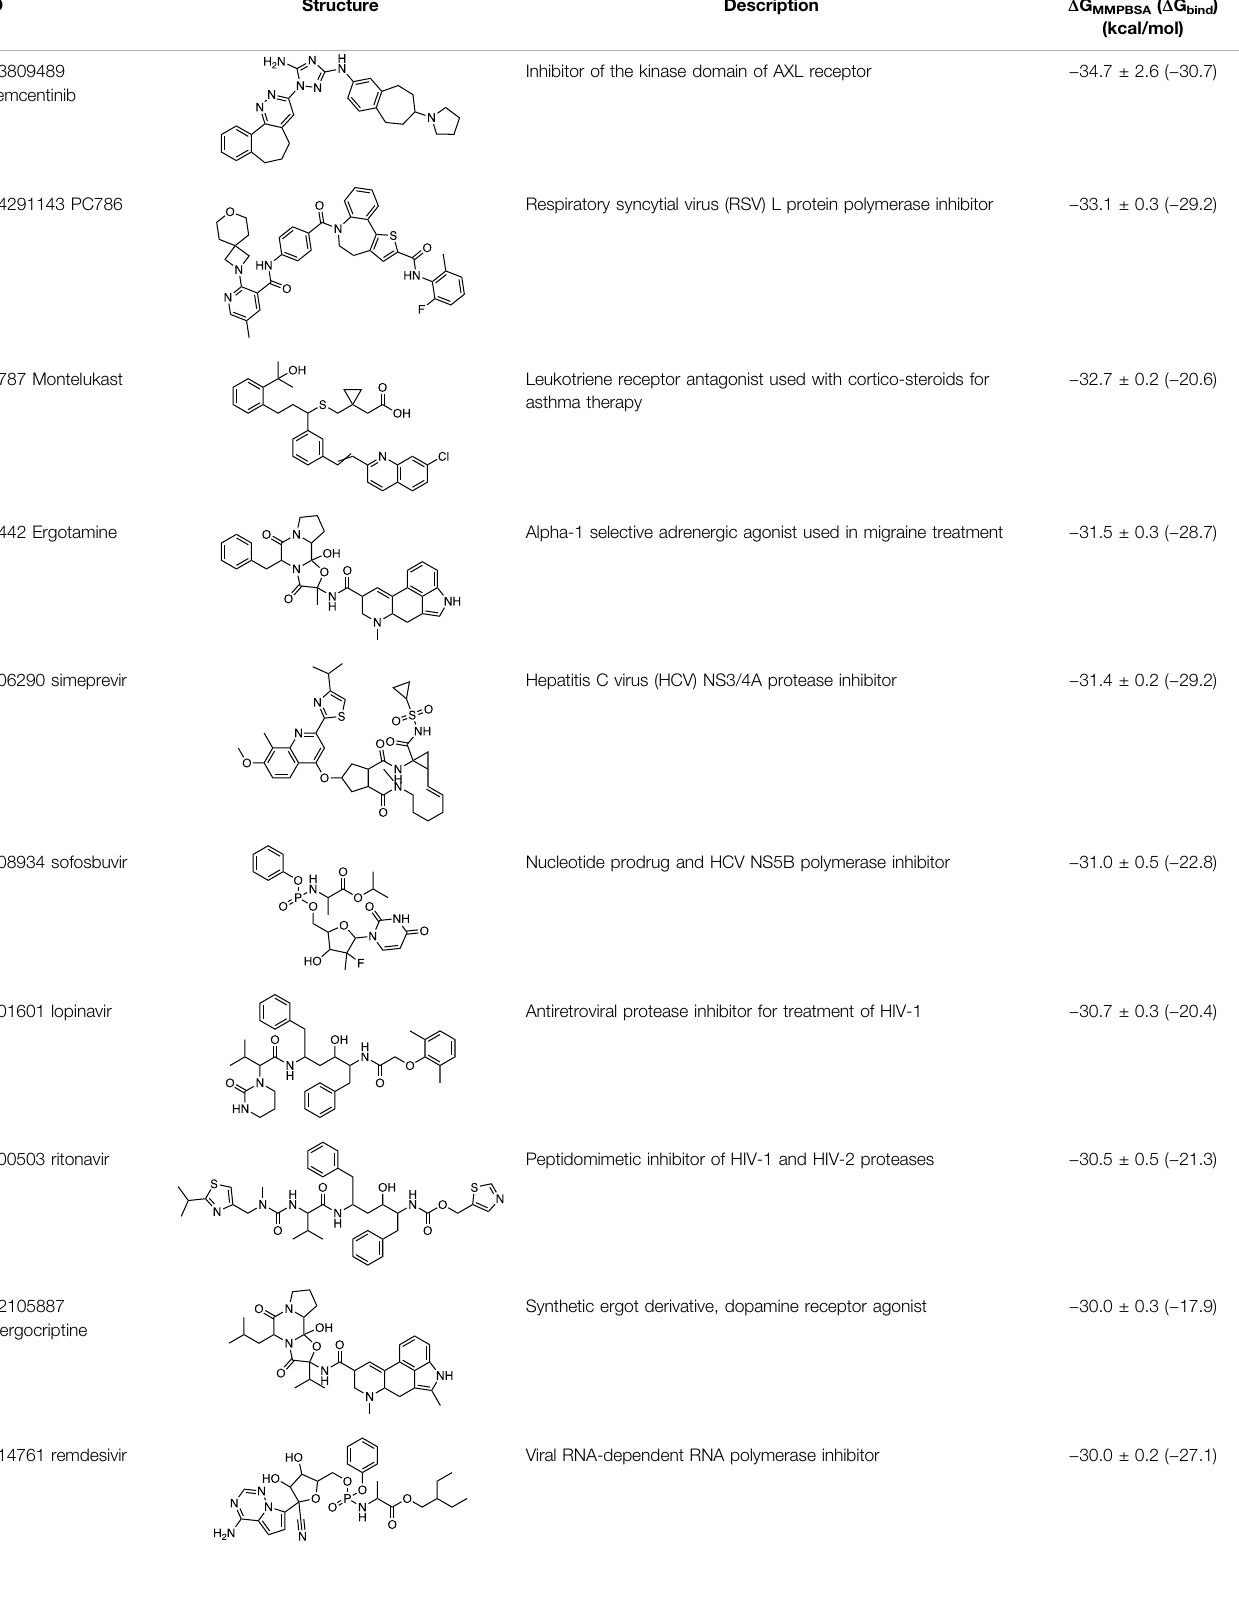
TABLE 1 | Binding energies of 10 top ranked small-molecule ligands for SARS-CoV-2 M pro .